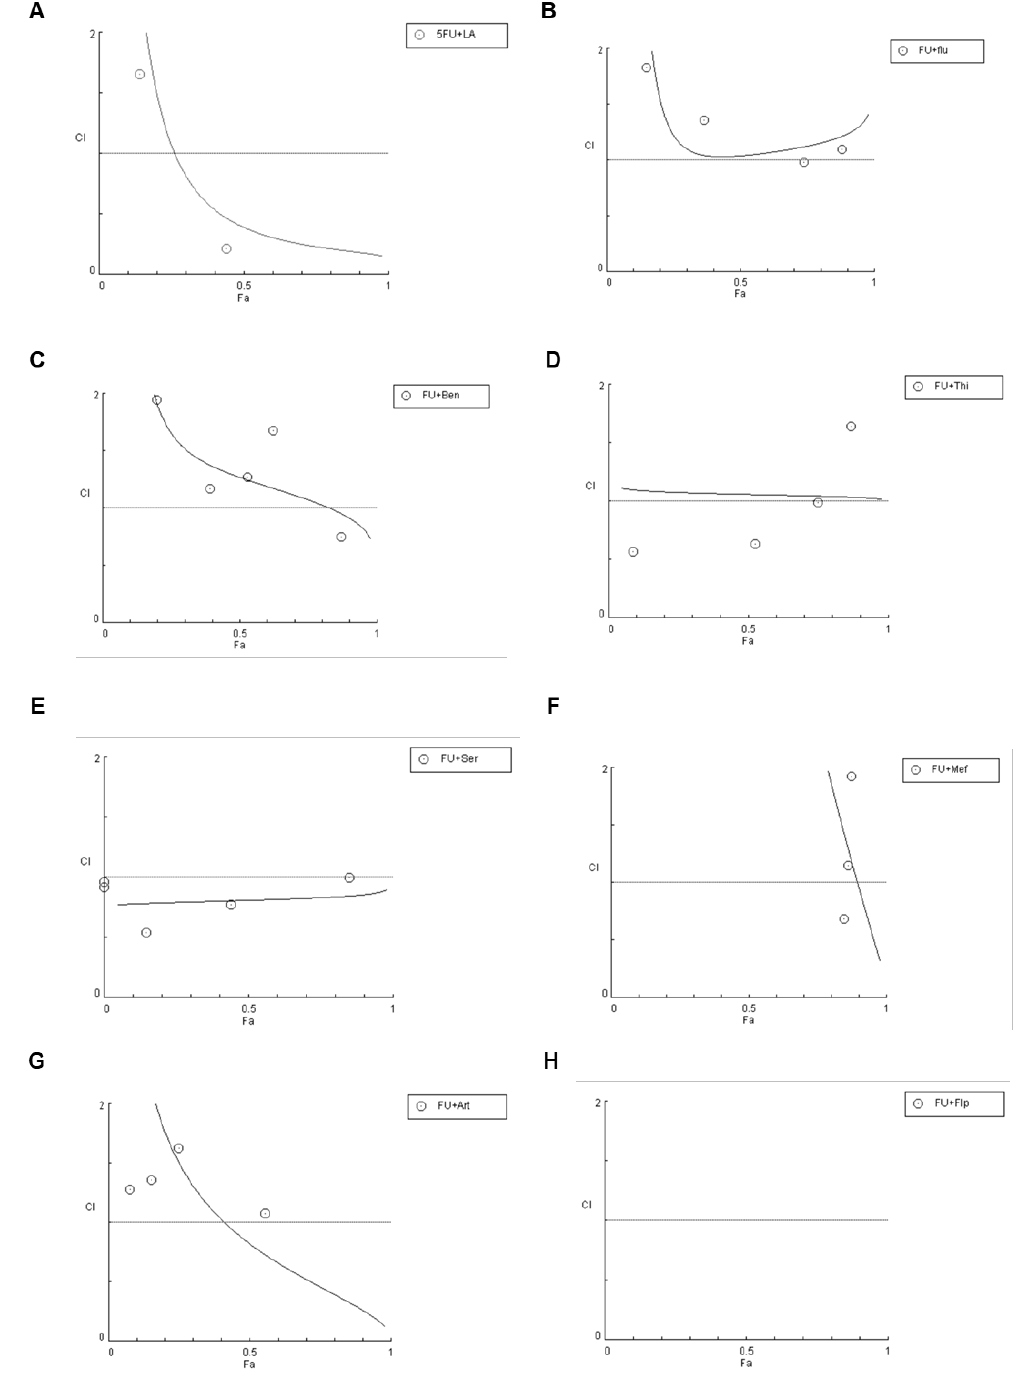
Figure 8. Chou-Talalay method Fa-CI plot of 5-FU plus latrepirdine ( A ), fluoxetine ( B ), benztropine ( C ), thioridazine ( D ), sertraline ( E ), mefloquine ( F ), artesunate ( G ) and fluphenazine ( H ). CI was plotted on the y -axis as a function of effect level (Fa) on the x -axis to evaluate drug synergism. CI < 1, CI = 1 and CI > 1 refers to synergism, additivity and antagonism, respectively.